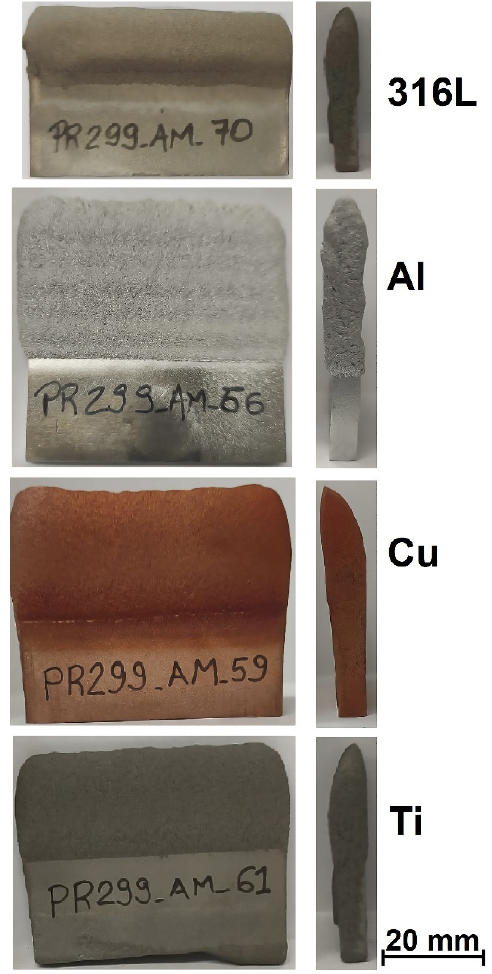
Figure 12. CSAM part on narrow substrate surface made by Metal Knitting strategy.